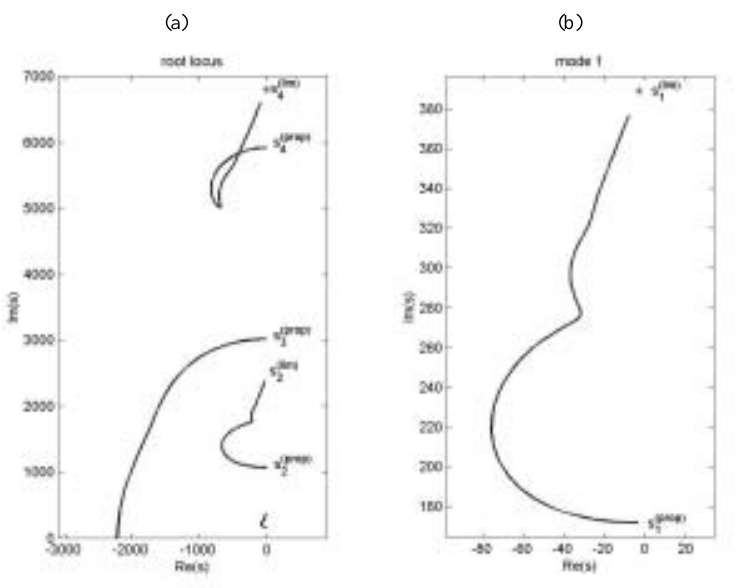
Fig. 2. (a) root loci for external damping; c 1 increases and c 2 remains unchanged (non-proportional damping); (b) zoom on first